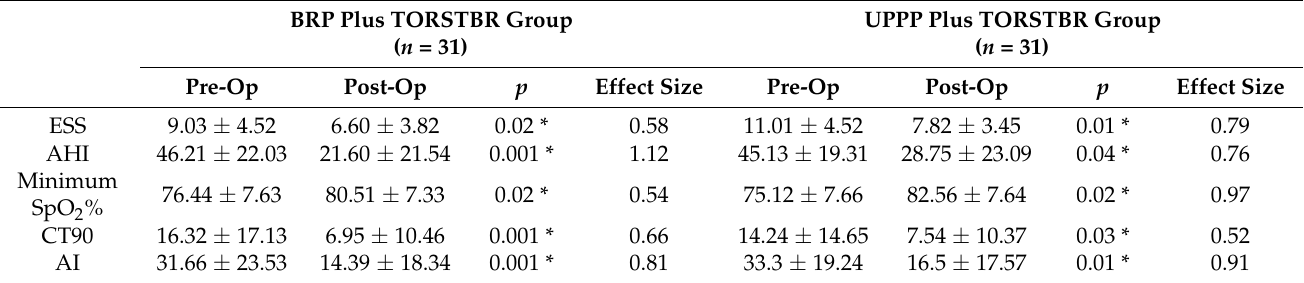
Table 2. Within-group comparison of the treatment